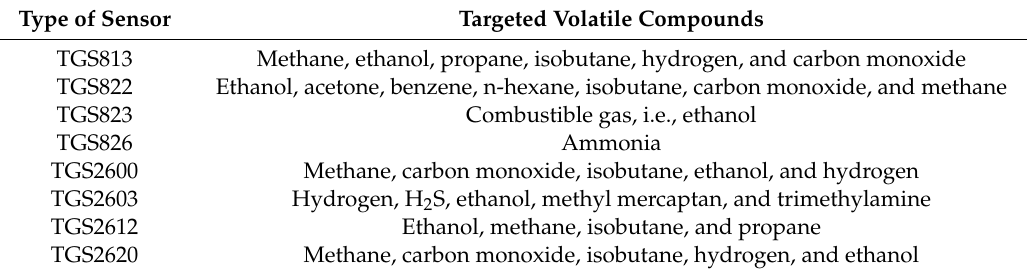
Table 1. Sensor types used in the lab-made e-nose and the targeted volatile compounds